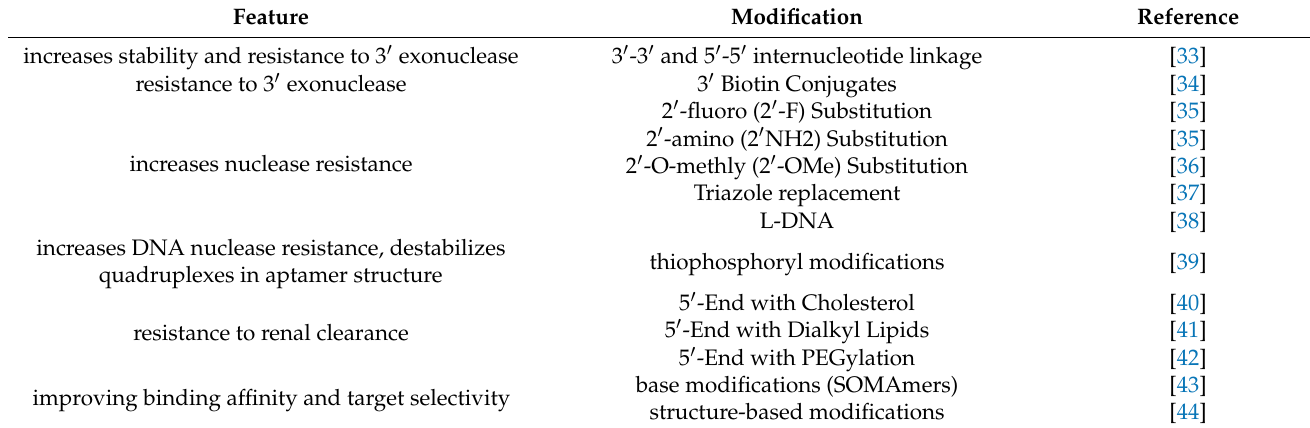
Table 2. Possible Aptamer Modifications with their